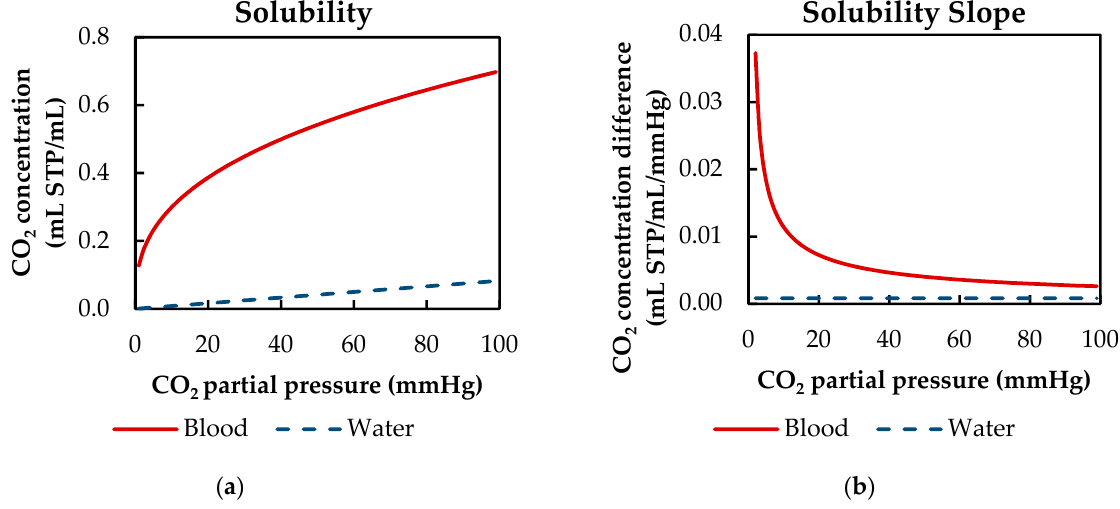
Figure 1. CO 2 solubility behavior of water (Henry [9]) and blood (Loeppky et al. [10]): ( a ) CO 2 concentration in dependency of CO 2 partial pressure; ( b ) slope of CO 2 concentration in dependency of CO 2 partial pressure.